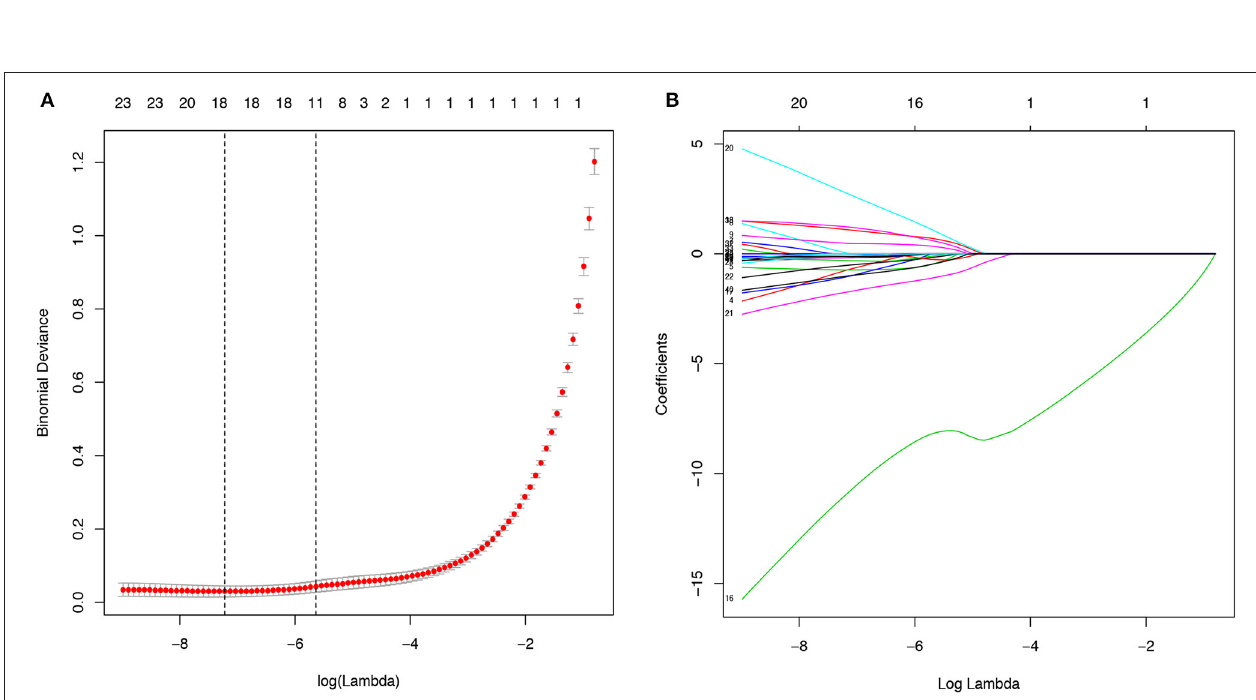
FIGURE 2 | Potential predictors selection using the least absolute shrinkage and selection operator (LASSO) regression model. (A) . The binomial deviance curve was plotted versus log( λ ). Dotted vertical lines were drawn at the optimal values by using the minimum criteria and the one standard error of the minimum criteria (the 1-SE criteria). (B) . LASSO coefficient profiles of the 40 alternative variables. A coefficient profile plot was produced against the log ( λ ) sequence.